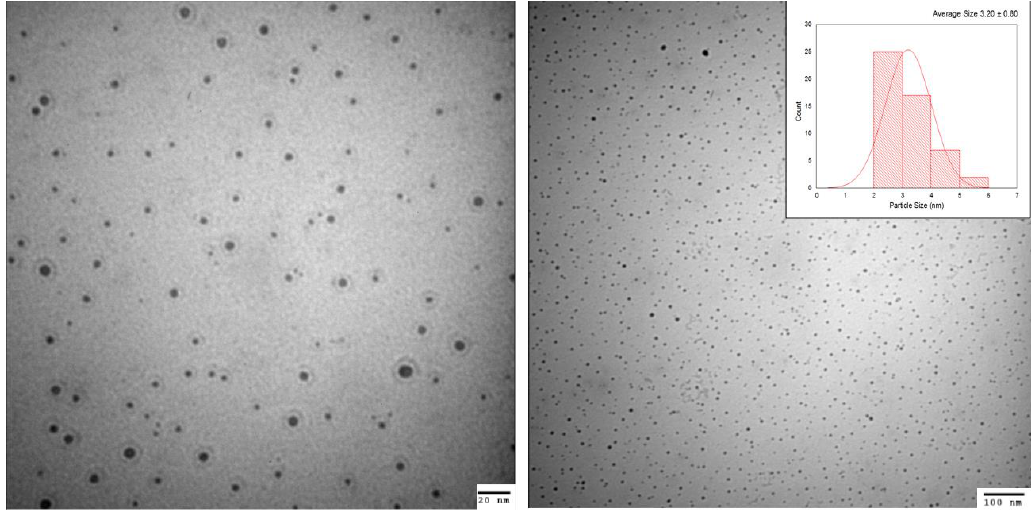
Figure 1. TEM Images of 5-(trimethylammonio)pentanethiolate-capped PdNP.